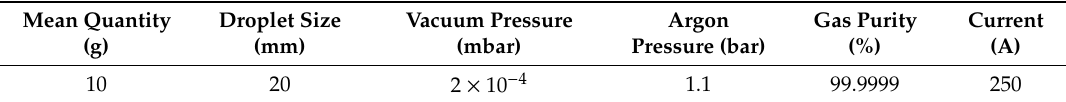
Table 1. Arc-furnace parameters.